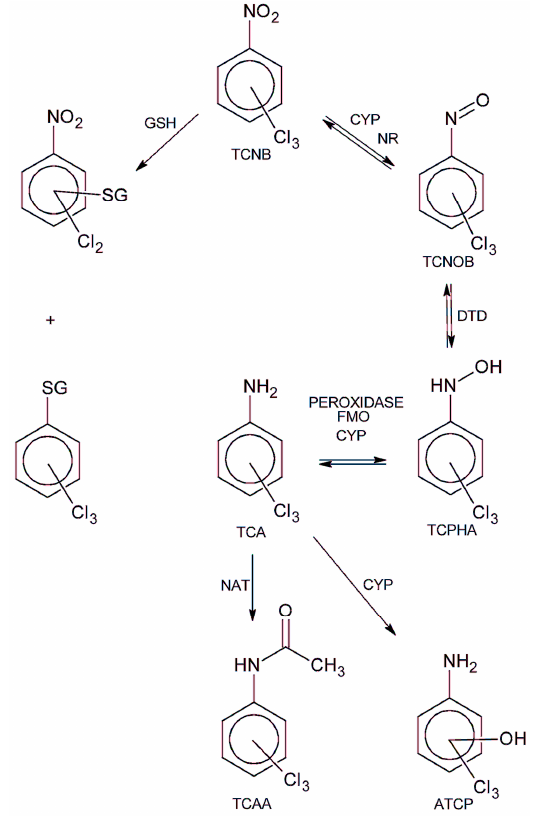
Figure 8. Putative biotransformation pathway for the TCNBs. ATCP = aminotrichlorophenol, CYP = cytochrome P450, DTD = DT-diaphorase, FMO = Flavin monooxygenase, GSH = glutathione, NAT = N -acetyltransferase, NR = nitroreductase, TCA = trichloroanilines, TCAA = trichloroacetanilide, TCNOP = trichloronitrosobenzene, TCPHA = trichlorophenylhydroxylamine.